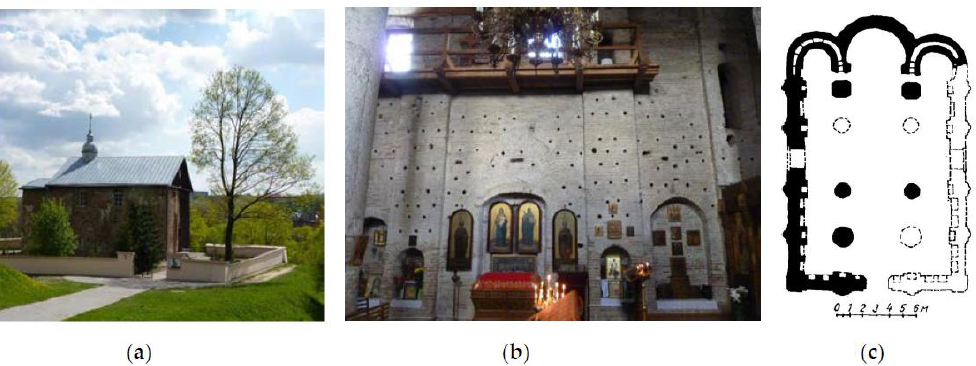
Figure 5. The Kalozha Church in Grodno ( a ), its interior ( b ) and its plan ( c ) with the destroyed walls marked by the dotted lines.